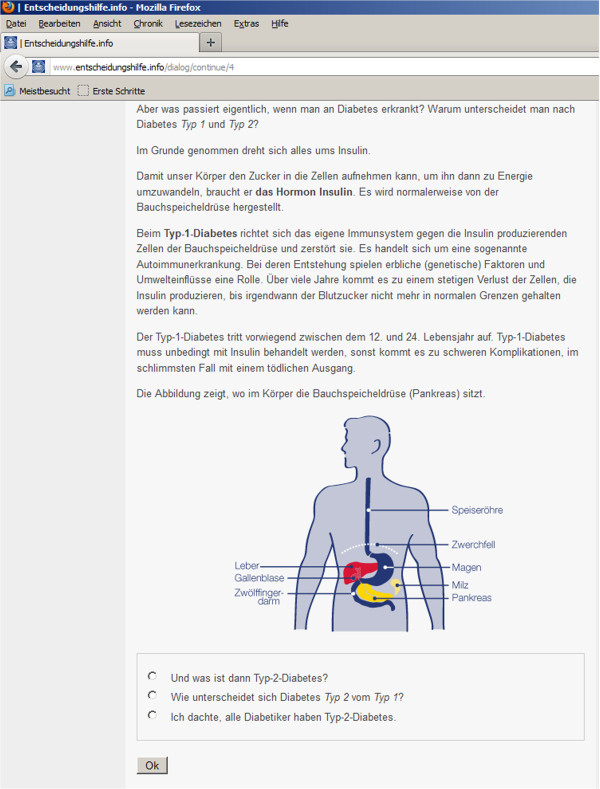
Dialogue window.